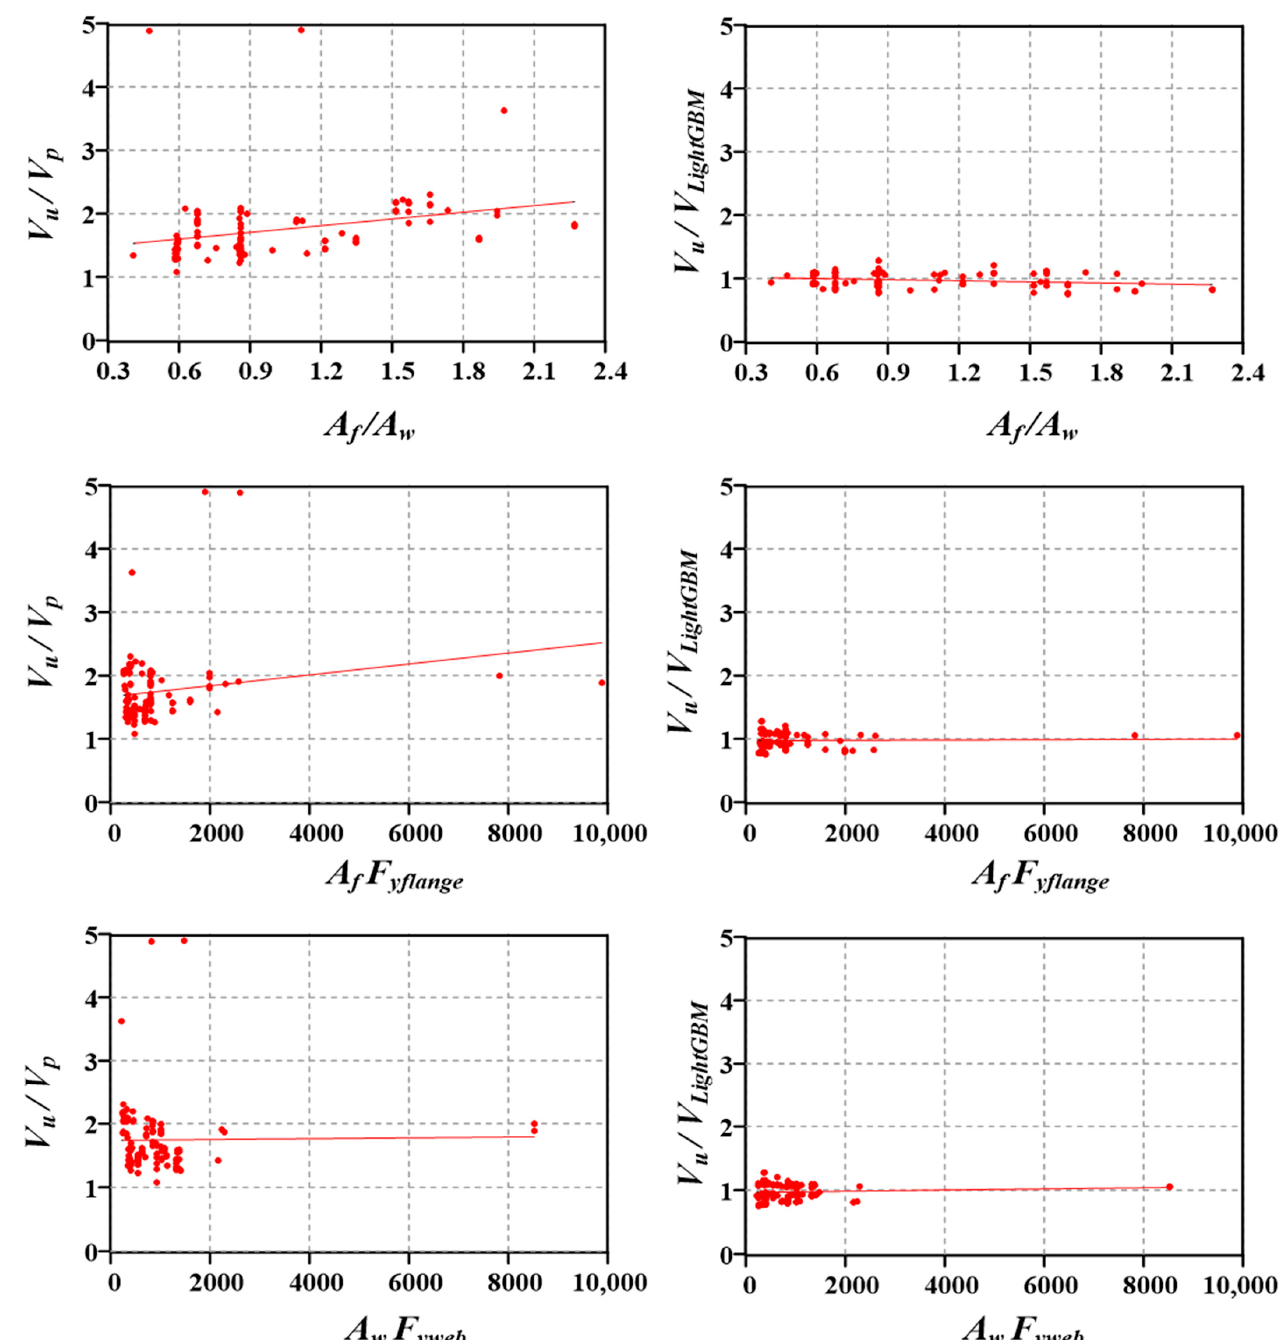
Figure 11. Distribution of overstrength ratio for the built-up